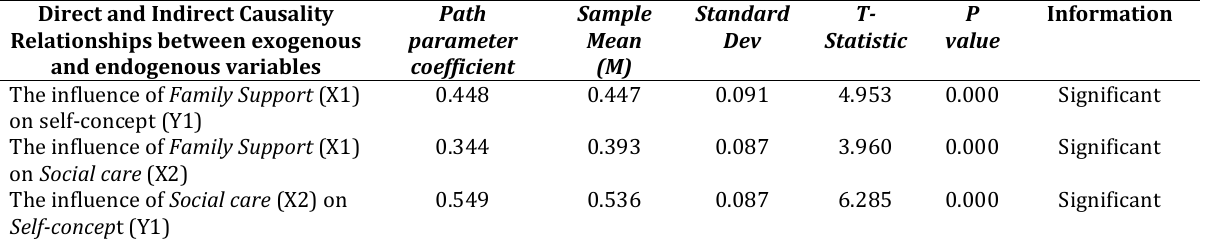
Table 6. T-Statistic Value on Inner Model of Self- Concept of Leprosy Patients Direct and Indirect